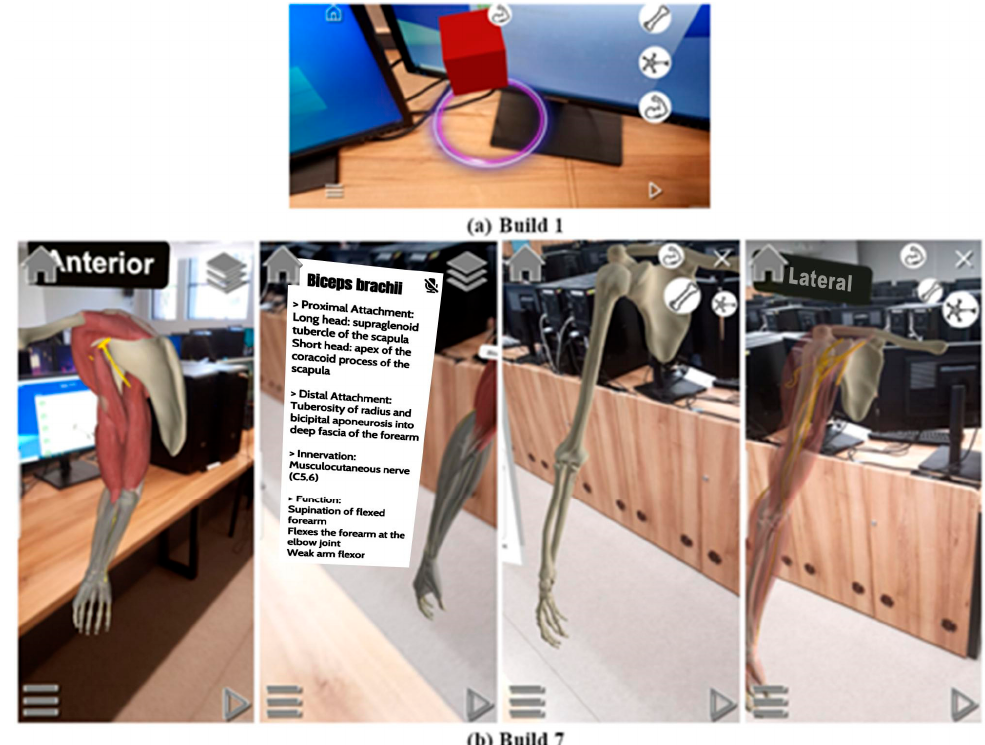
Figure 7. The changes made to the AR mode, including final UI design and placement, during application development.